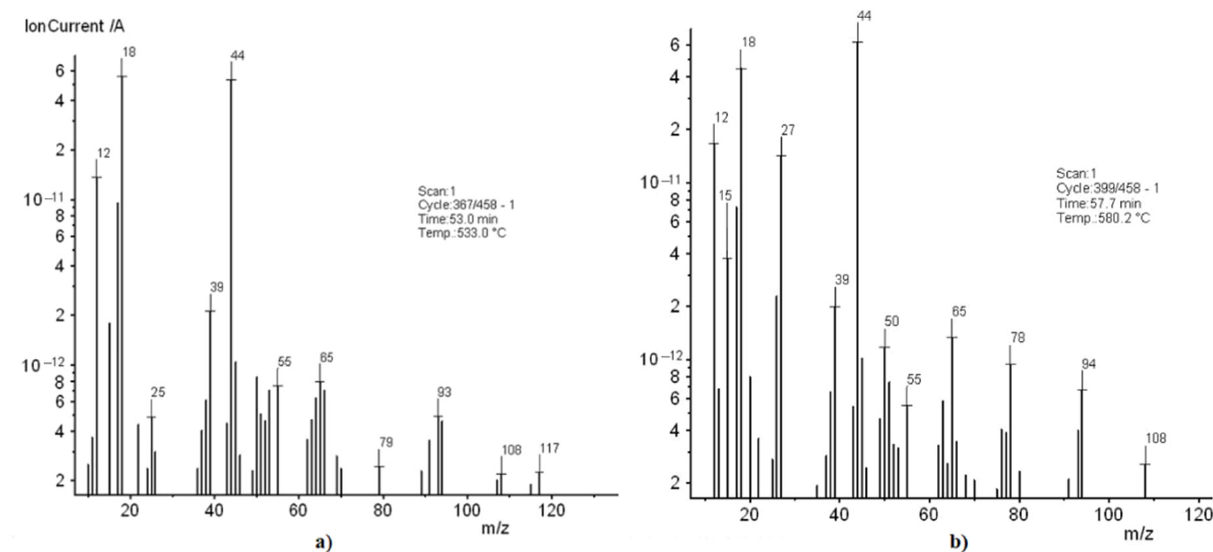
Figure 4. MS spectra for thermal degradation of PEI-2 in nitrogen at 533 ◦ C ( a ) and 580 ◦ C ( b ).